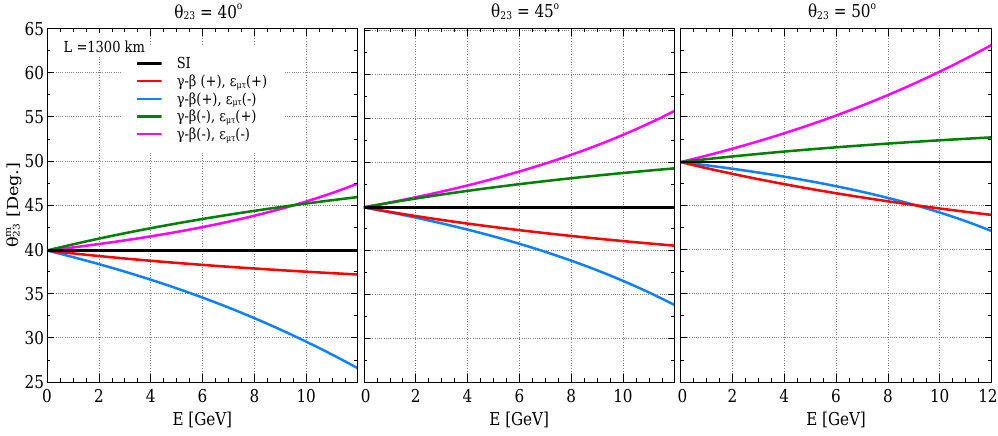
(given in eq. (3.9)) with neutrino energy in matter with SI and NSI Figure 2 . Evolution of θ m 23 considering both ( γ − β ) and ε non-zero at-a-time. Black curve in each column represents the SI µτ case while the other curves show the cases with four possible combinations of the sign of ( γ − β ) and ε µτ with magnitude 0.2. The left, middle, and right column correspond to the evolution considering three values of θ in vacuum, 40 ◦ , 45 ◦ , and 50 ◦ , respectively. We consider L = 1300 km and assume 23 NMO. Values of the oscillation parameters in vacuum used in this plot are taken from table